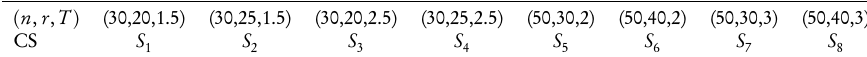
Censoring schemes for Monte Carlo simulation study.